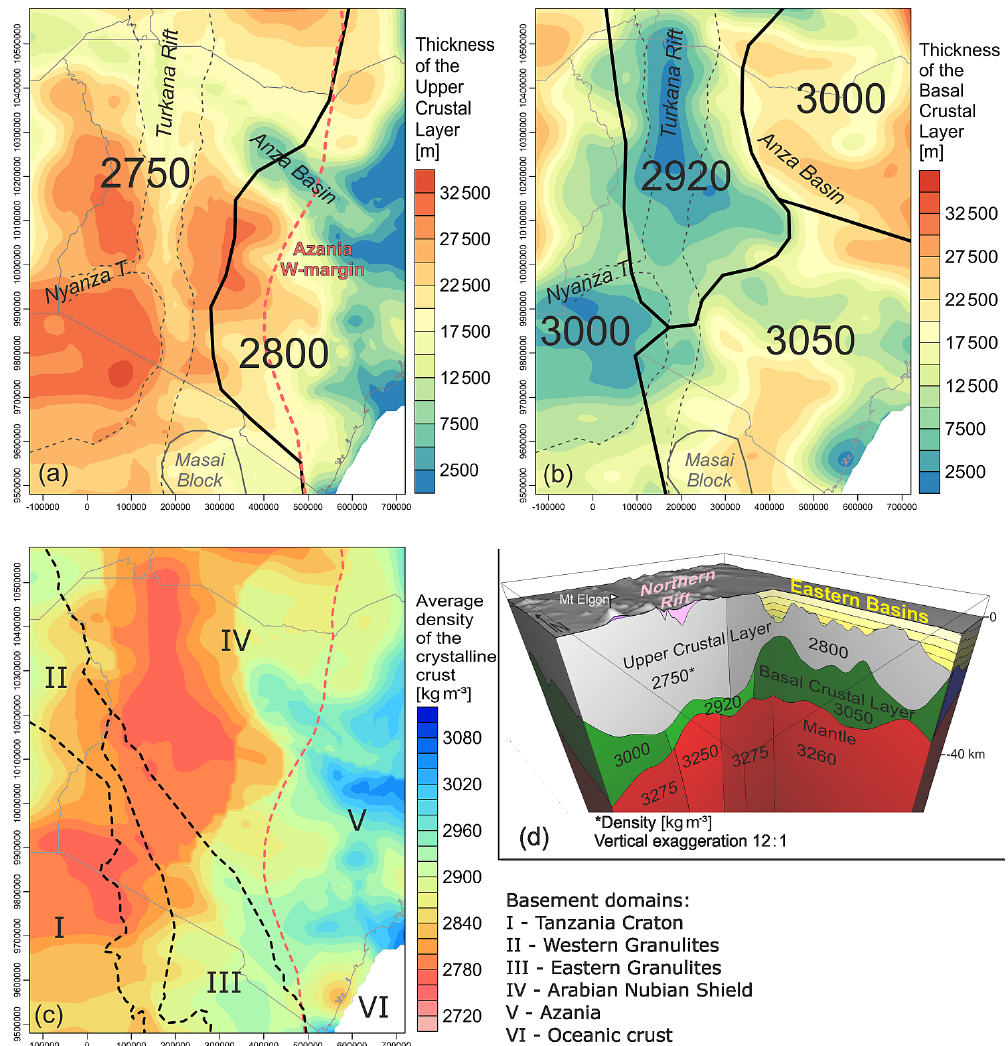
Figure 7. Gravity-constrained 3-D density configuration of the sub-sedimentary continental crust. (a) Thickness of the continental upper crustal layer; solid black line separates domains of different average density [kgm − 3 ]; dashed red line denotes the western margin of the microcontinent Azania after Fritz et al. (2013); grey line denotes spatial extension of the Masai block as derived from Le Gall et al. (2008). (b) Thickness of the continental basal crustal layer; black lines separate domains of different average density [kgm − 3 ]. (c) Average density of the crystalline continental crust calculated by vertically averaging the densities of the upper and basal crustal layers according to their share in the total thickness of the crust; dashed lines delineate basement domains of Fritz et al. (2013). (d) Perspective view into the 3-D density model; for densities of units also refer to Table 2 (sedimentary and volcanic), Table 4 (crystalline crust) and Fig. 5 (shallow